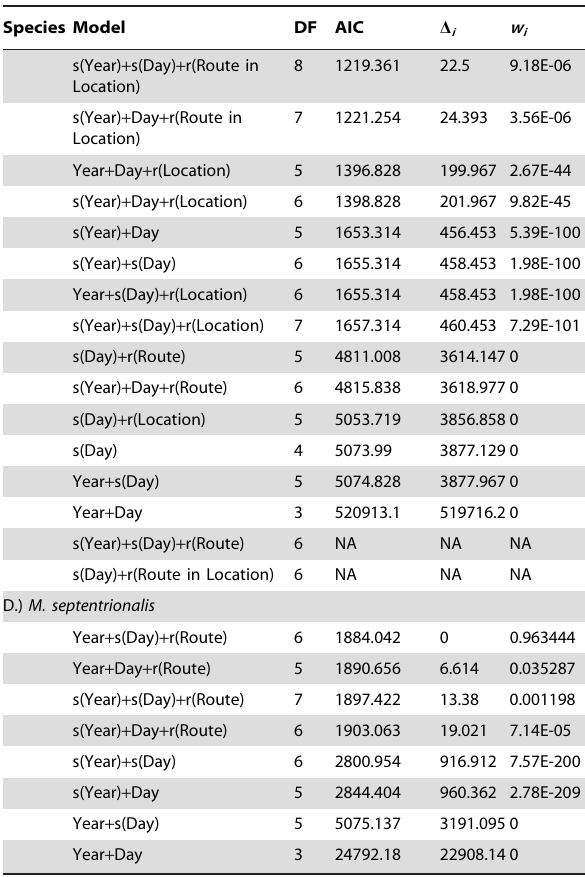
Table 1. Model selection. Table 1.